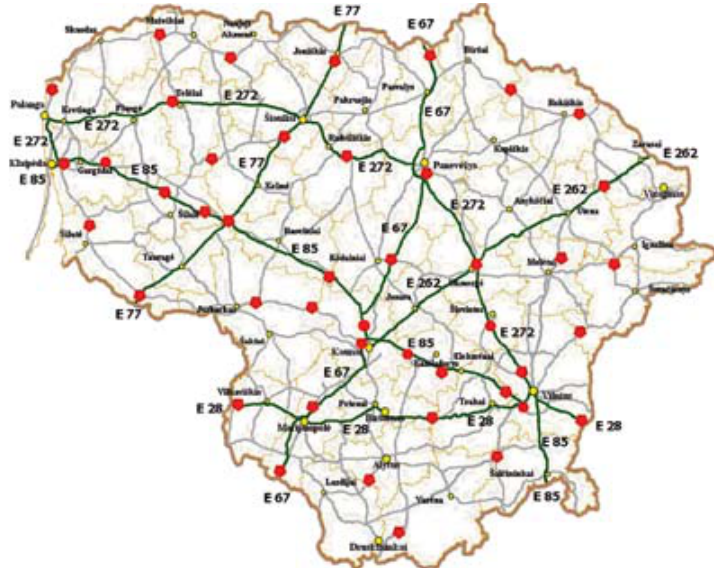
fig. 2. Distribution of RWIS stations (Laurinavičius et al. 2007):  –